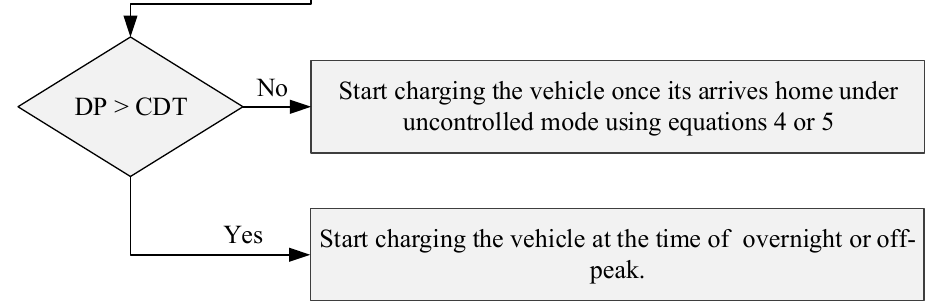
Figure 6. Main procedures for simulating the EV charging load under overnight and off-peak sce-